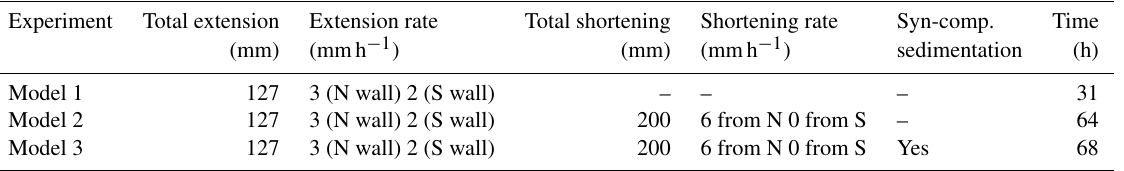
Table 2. Experimental programme.